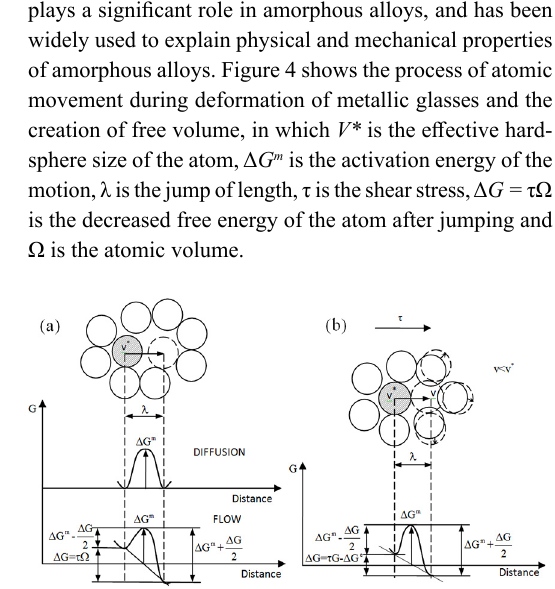
For an atom jump, it must have a nearest neighbor environment as shown in Figure 4 (a), and the nearby area also must have enough space to accommodate its atomic volume V *. In this jumping process, the local free energy is minimal and some Δ G m must be supplied. The number of jumps across the activation barrier is the same in both directions, when Δ G m is obtained from thermal fluctuations. However, at an applied stress, the number of forward jumps across the activation barrier ( ) is larger than that of backward jumps ( ), and this results in a net forward flux of atoms and forms the basic mechanism for flow. Figure 4 (b) shows the creation of the free